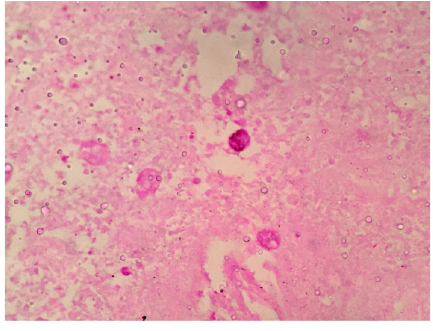
Figure 6: Periodic acid-Schiff (PAS) positive amoebic